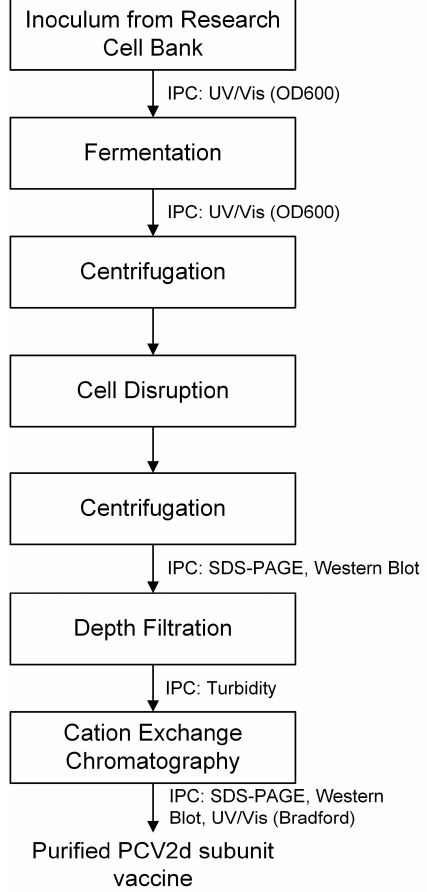
Figure 1. PCV2d process flow diagram. IPC = in-process